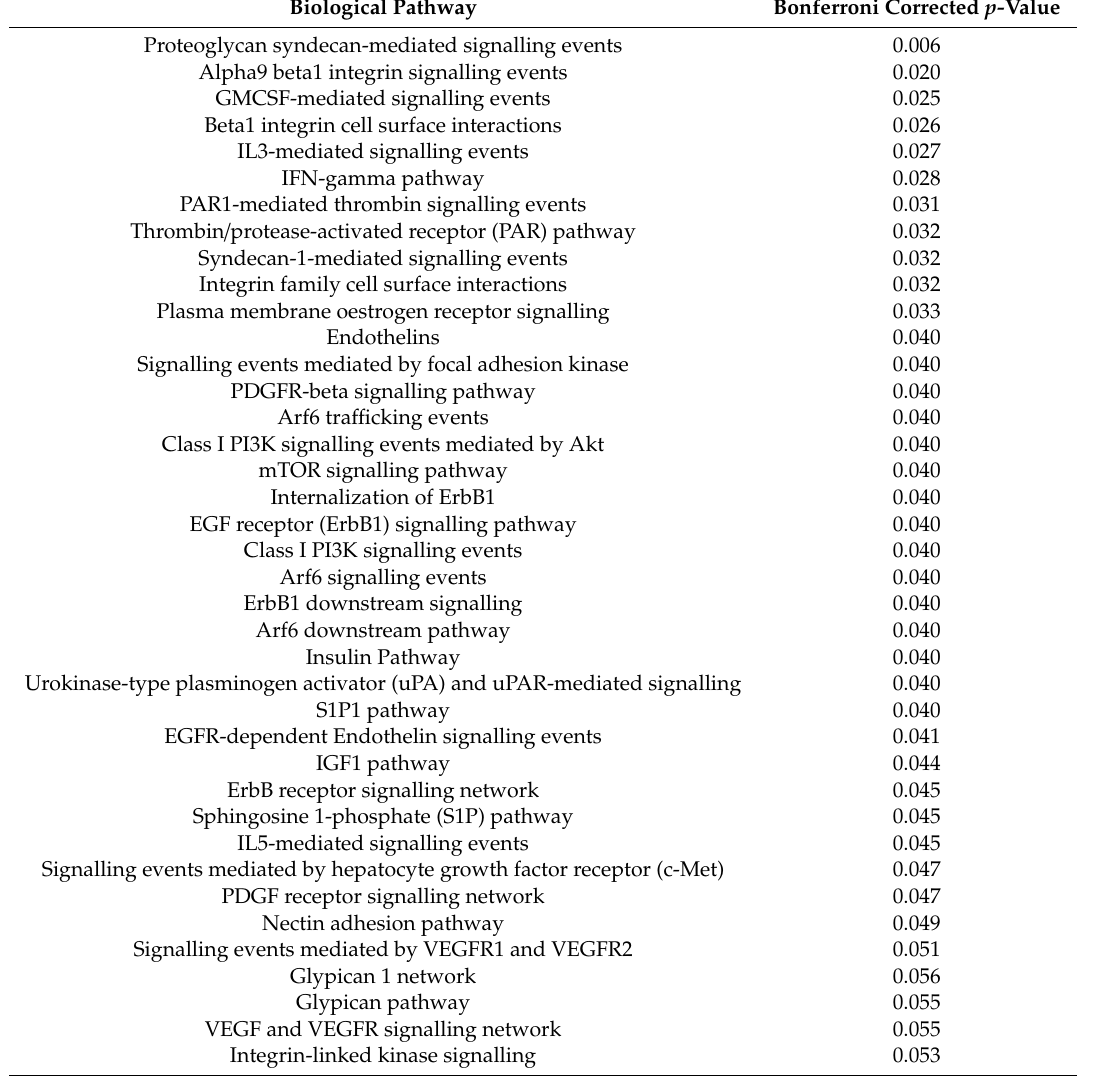
Table 3. Signalling pathways significantly enriched in genes modulated in RA